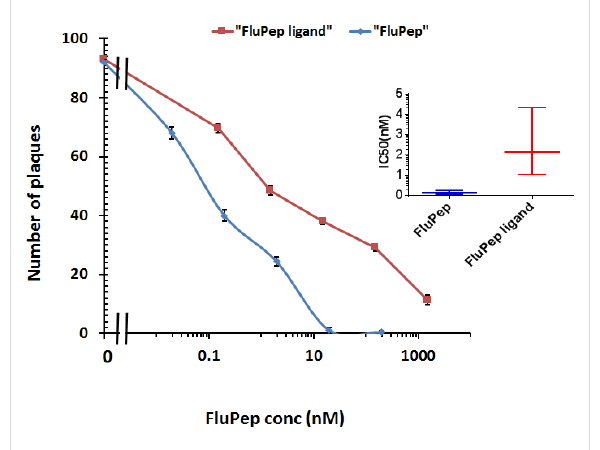
Figure 3: Determination of the half maximal inhibitory concentration (IC 50 ) of FluPep and and FluPep ligand in a plaque assay. Inhibition of plaque formation as a function of the concentration of FluPep and FluPep ligand. Inset: IC 50 values. Results are the mean ± SD ( n = 3).